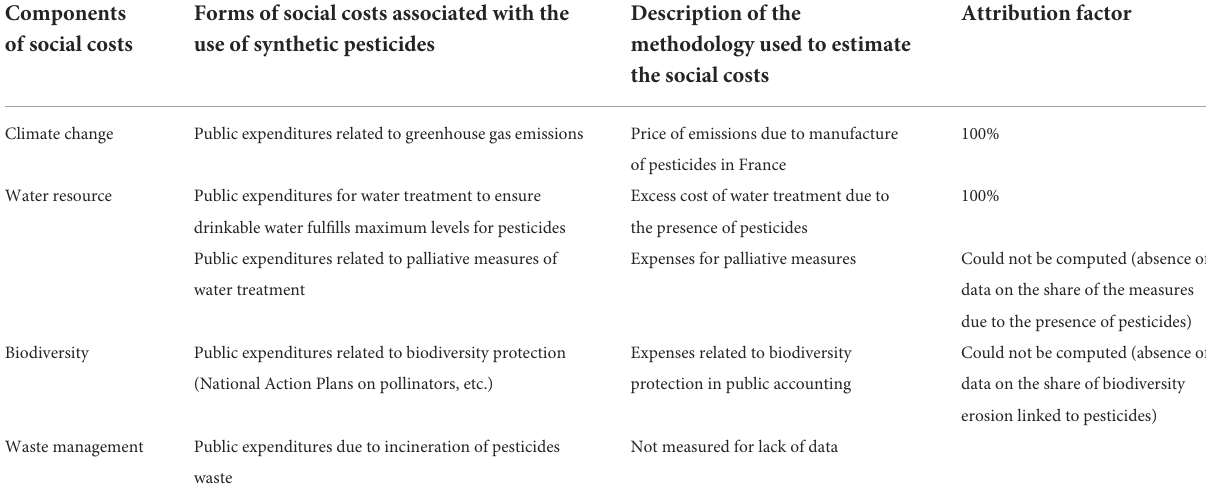
TABLE 2 Forms and description of the environmental costs associated with the use of synthetic pesticides in